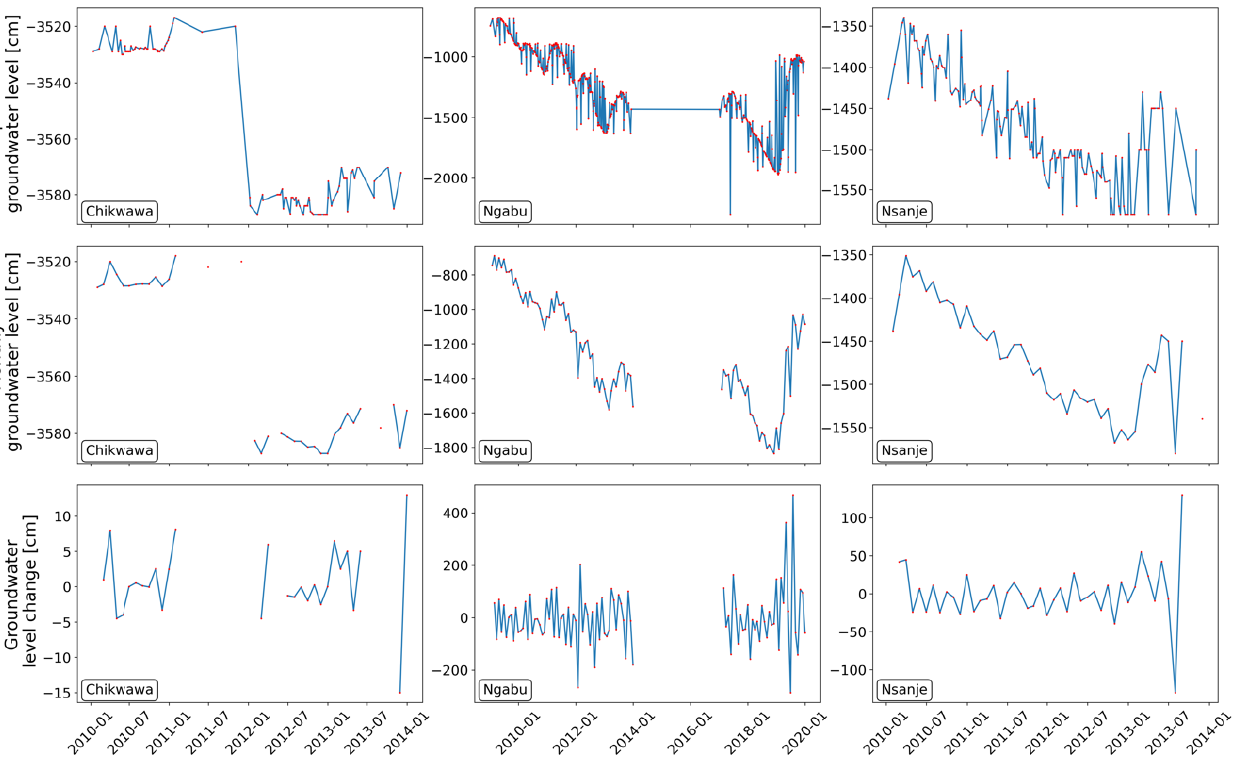
Figure 5. Hydrographs of the three monitoring boreholes in the Shire Valley Alluvial Aquifer. The first row illustrates the raw data, the second row shows the mean monthly groundwater levels, and the bottom row shows the monthly groundwater level changes.